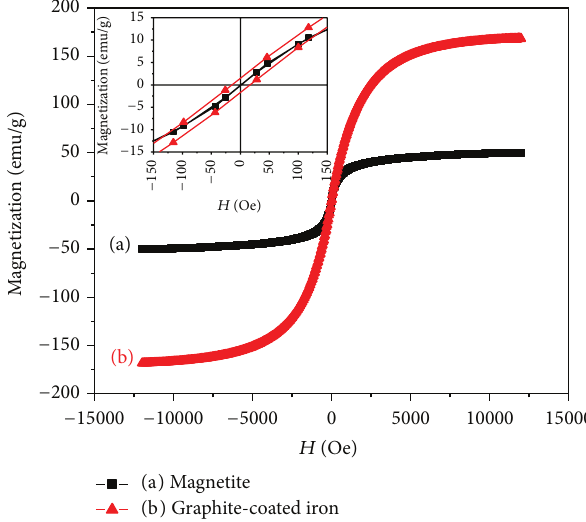
Figure 5: Magnetization curves at room temperature: magnetite nanoparticles (a) and graphite-coated iron nanoparticles (b). The inset displays the low field magnetization to illustrate the superpara- magnetic nature of our